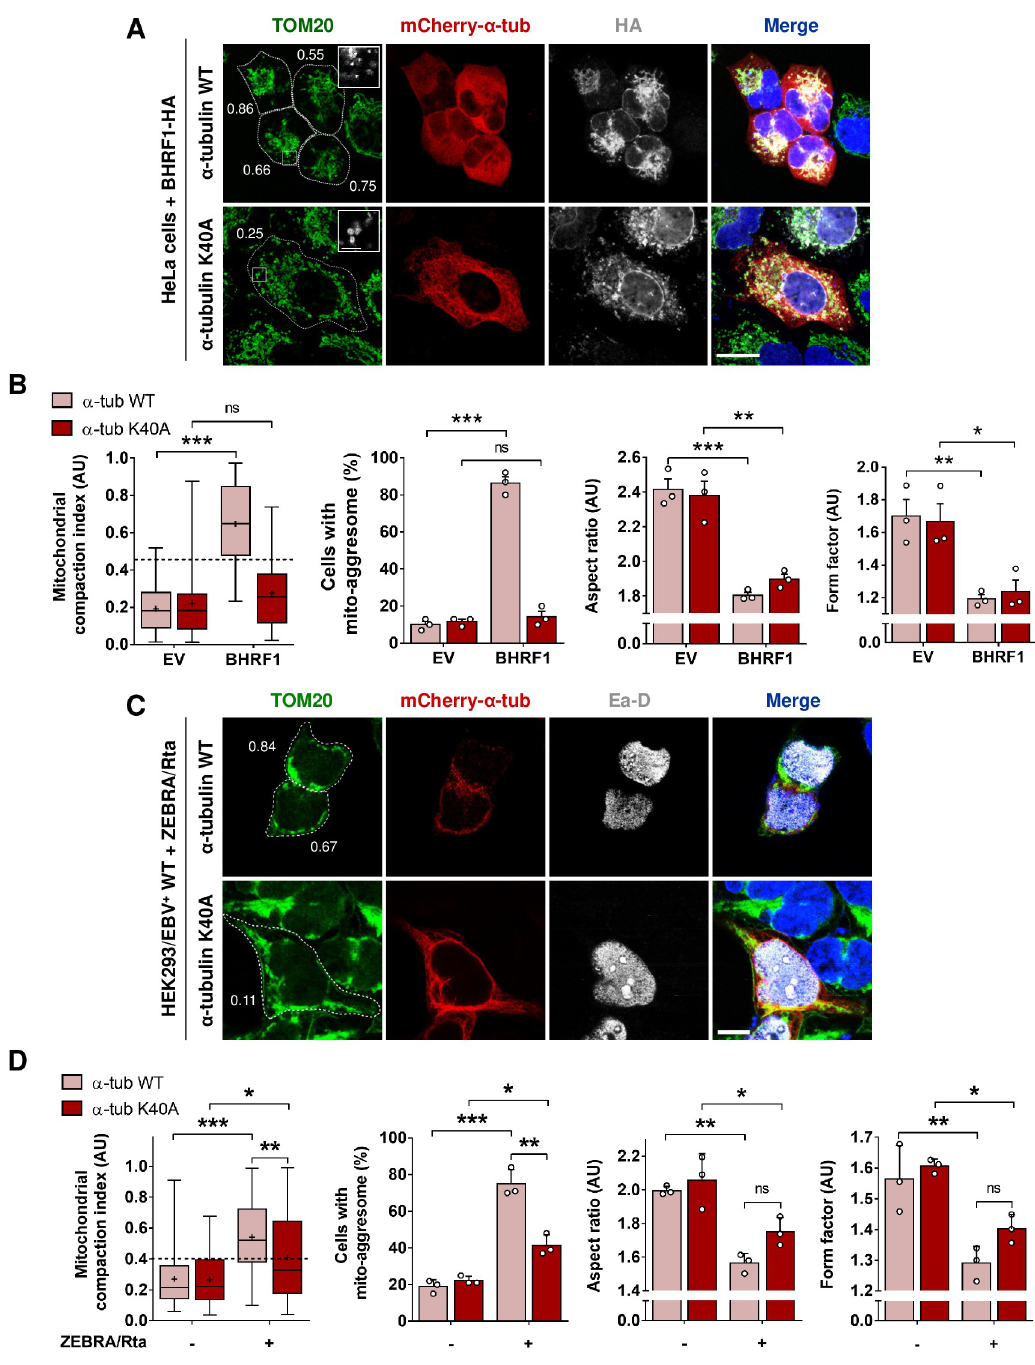
Fig 3. MT hyperacetylation is required for BHRF1-induced mito-aggresomes formation. (A-B) HeLa cells were co-transfected with plasmids encoding BHRF1-HA and either mCherry- α -tubulin WT or a non-acetylatable form (K40A). (A) Confocal images with insets (3X) of cells immunostained for HA and TOM20. Nuclei were stained with DAPI. Scale bars: 10 μ m and 4 μ m for insets. Values of mitochondrial CI are indicated on representative cells. Images of control cells are presented in S3B Fig. (B) Quantification of CI, percentage of cells with a mito-aggresome and mitochondrial fission parameters (n = 20 cells per condition). (C-D) HEK293/EBV + WT cells were co-transfected with plasmids encoding ZEBRA, Rta and either mCherry- α -tubulin WT or K40A. (C) Confocal images of cells immunostained for Ea-D and TOM20. Nuclei were stained with DAPI. Scale bar: 10 μ m. Values of mitochondrial CI are indicated on representative cells. (D) Quantification of CI, percentage of cells with a mito- aggresome and mitochondrial fission parameters (n = 20 cells per condition). Data represent the mean ± SEM of three independent experiments. ns = non-significant; � P < 0.05; �� P < 0.01; ��� P < 0.001 (Student’s t-test).